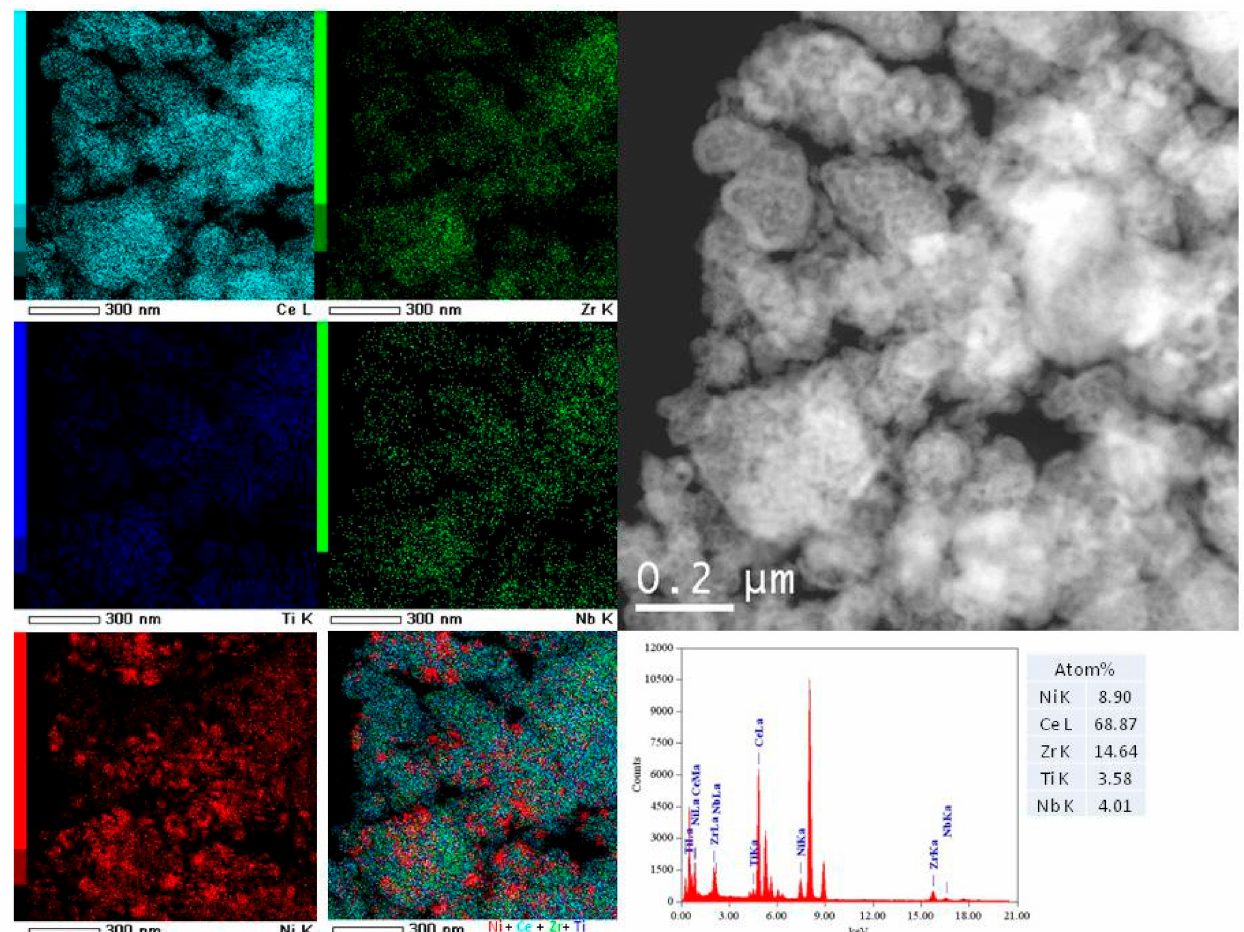
Figure 3. HAADF-STEM image with EDX analysis of NiCeTiNbZr-I